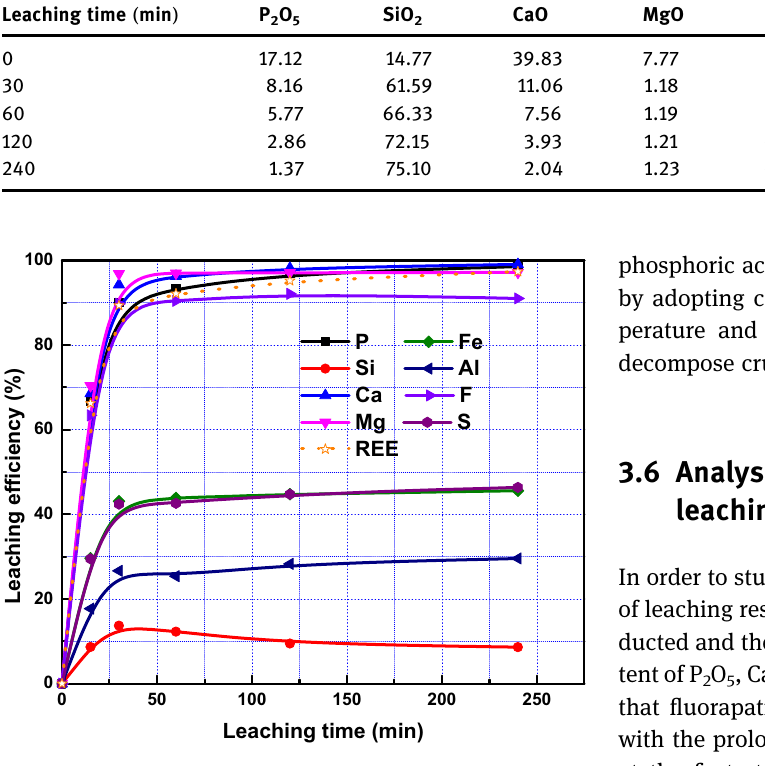
Figure 8: Leaching e ffi ciencies of various elements as a function of leaching time.